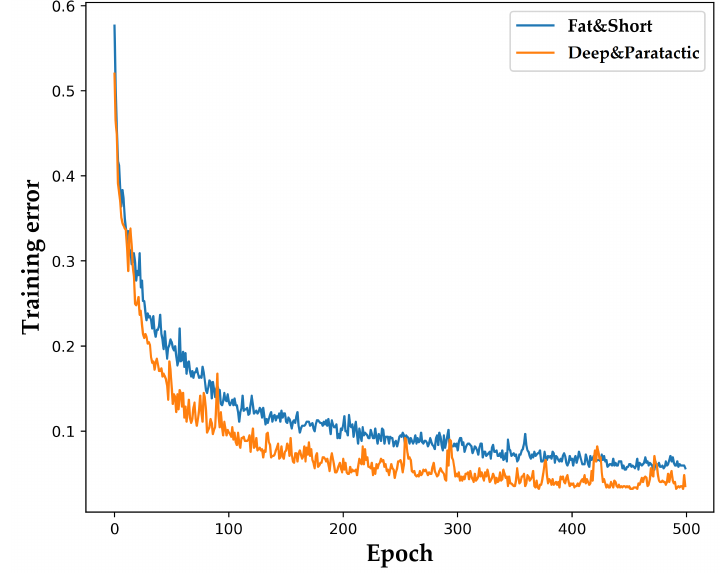
Figure 7. Performance comparison of different network